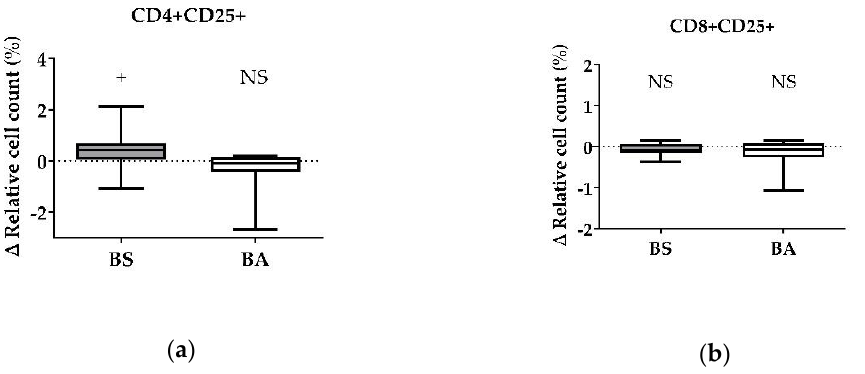
Figure 4. Influence of cell-free culture supernatants of B. subtilis DSM 32315 (grey) and B. amyloliquefaciens CECT 5940 (white) on the activation of T cells. Isolated PBMCs were treated with either cell-free supernatants of BS or BA, or left untreated (negative control). After treatment for 24 h, immune cells were stained with monoclonal antibodies. The relative cell count was related to heat-treated controls. DAPI was used as a viability marker. ( a ) CD4+CD25+ activated T-helper cells and ( b ) CD8+CD25+ activated cytotoxic T cells relative to the vital PBMC cell count. 20,000 vital PBMCs were recorded on a BD FACSCanto II flow cytometer. Data represent 13 (BS) or 12 (BA) biological replicates. Results are presented as box and whisker plots showing the median, with a 25 – 75 percentile range as the box and minimum to maximum as the whiskers. Significance is shown as +, p < 0.1; NS: not significant.